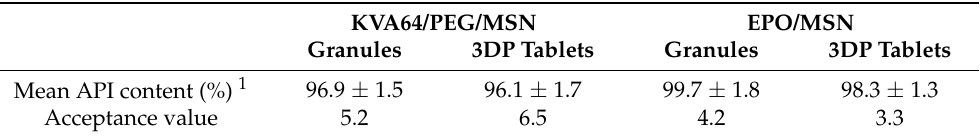
Table 4. Drug content uniformity of MSN in KVA64/PEG/MSN and EPO/MSN granules and